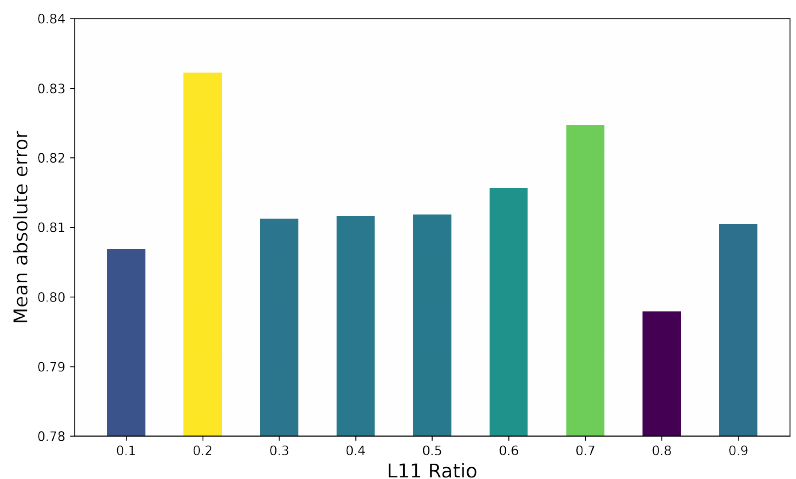
Figure 9. Impacts of L11 ratio on QSAR dataset.